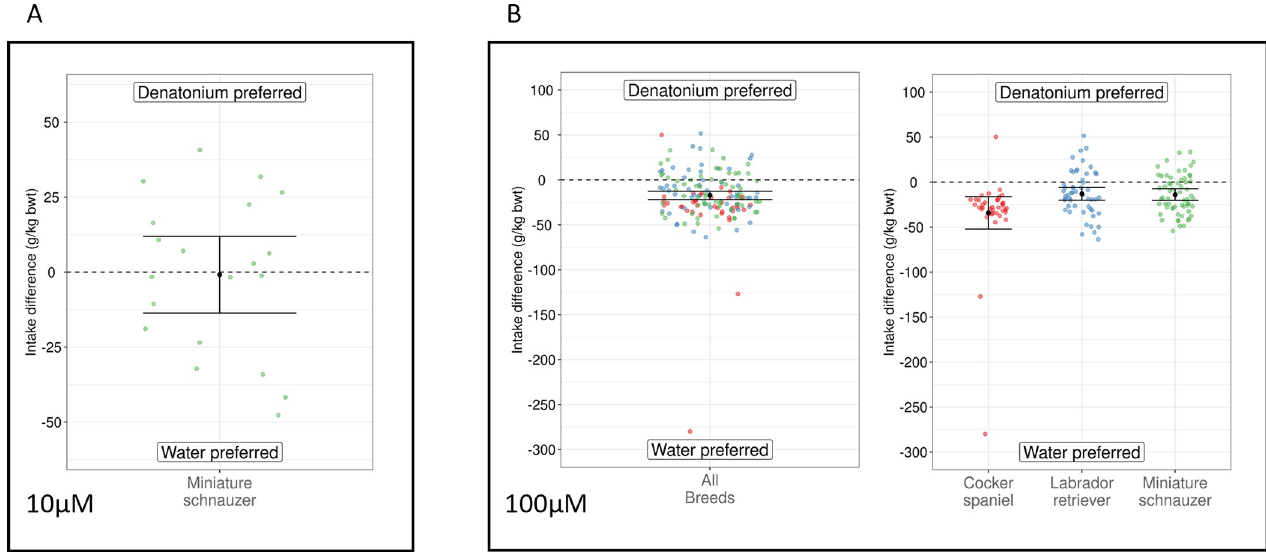
Fig 5. Responses of dogs to DB at concentrations of 10 μ M and 100 μ M vs water. Data are shown as intake difference in g/kg bodyweight. Data points show each individual exposure event. A) Ten miniature schnauzers were exposed to 10 μ M DB and water on two consecutive days, showing no significant difference in preference (mean = 0.866, 95%CI = -13.656 to 11.923, p = 0.883). B) 76 dogs of three different breeds were exposed to 100 μ M DB on two consecutive days, showing a significant mean preference for water over DB, (mean = -16.949, 95%CI = -21.931 to -12.590, p < 0.001). When data from the three breeds are analysed independently, cocker spaniels (mean = -34.132, 95%CI = -54.020 and -14.244, p < 0.001), Labrador retrievers (mean = -12.955, 95%CI = -20.872 and -5.039, p < 0.001), and miniature schnauzers (mean = -13.828, 95%CI = -20.939 and -6.717, p < 0.001) all demonstrated a significant mean preference for water over DB. The Tukey post-hoc multiple comparison test was used to produce p